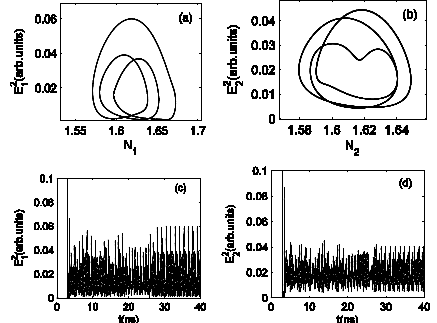
Fig. 3. Different quasi-cycle orbits of two lasers and output. (a) a cycle-3 orbit of laser 1. (b) a cycle-5 orbit of laser 2. (c) laser 1out. (d) laser 2